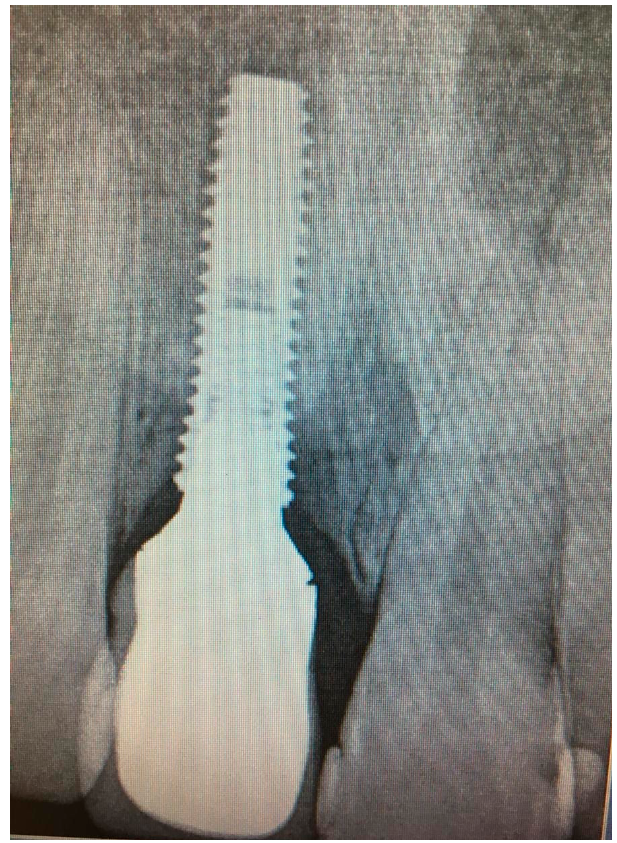
Figure 9. X-ray of patient in 6 months after treatment.